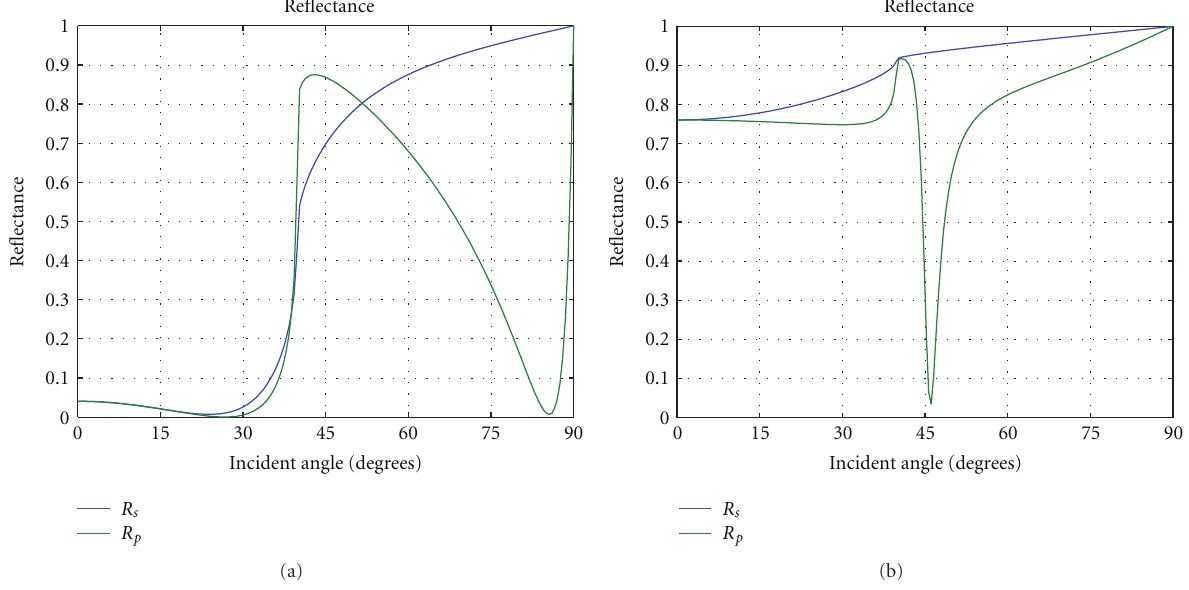
Figure 4: ATR results for 7nm Al, 27 nm Al 2 O 3 , 7nm Al stack (left), and single 20 nm Al layer (right).